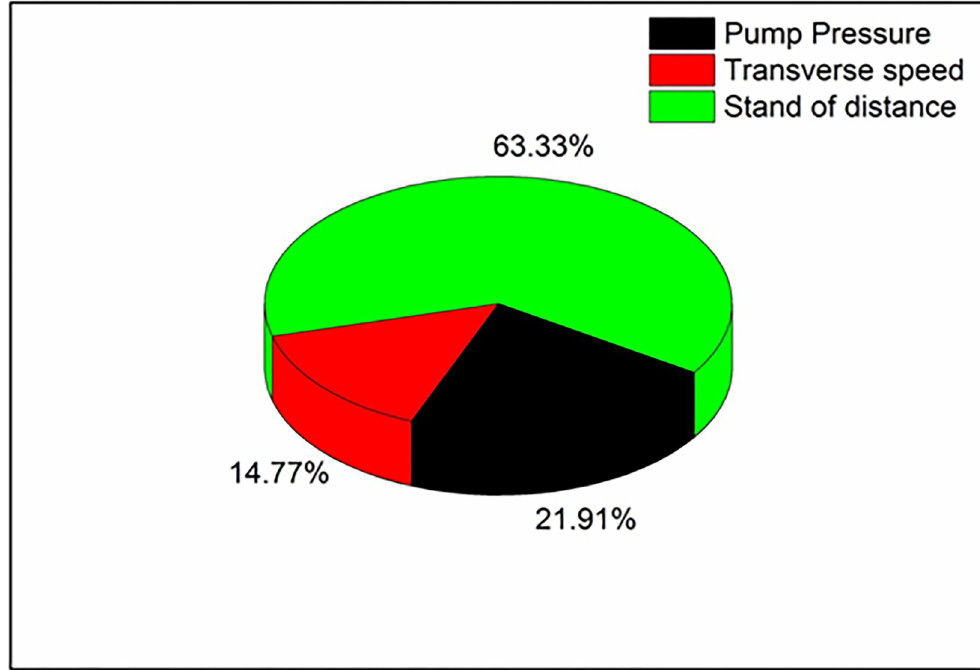
Fig 7. Contribution of machining parameters in epoxy glass fibre composite.